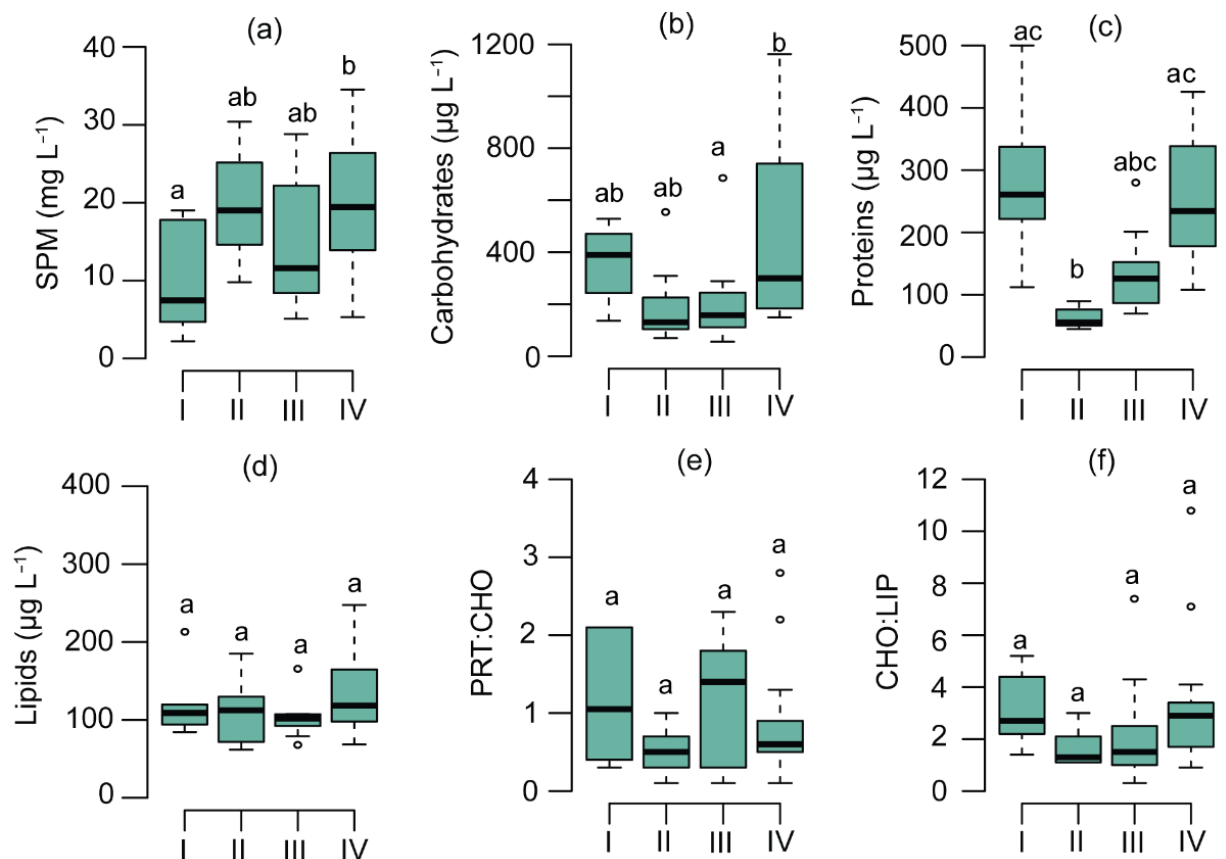
Figure 4. Box and whisker plots of the four clusters showing the variations in the concentrations of ( a ) total suspended particulate matter (SPM), ( b ) carbohydrates (CHO), ( c ) proteins (PRT), and ( d ) lipids (LIP) of POM; ( e ) protein-to-carbohydrate ratio (PRT:CHO); and ( f ) carbohydrate-to-lipid ratio (CHO:LIP) in each cluster. The median value of each cluster is indicated by the horizontal bar inside the box. The same superscripts within each panel indicate statistically nonsignificant differences between clusters ( p > 0.05).